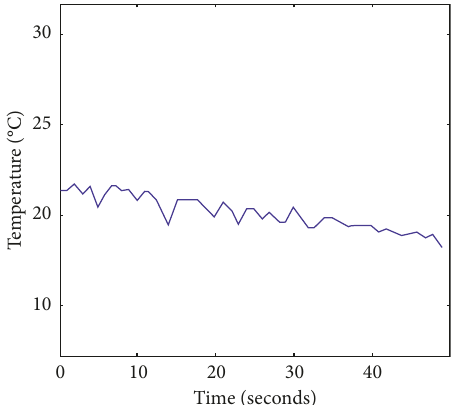
Figure 3: Temperature monitoring of a single patient.